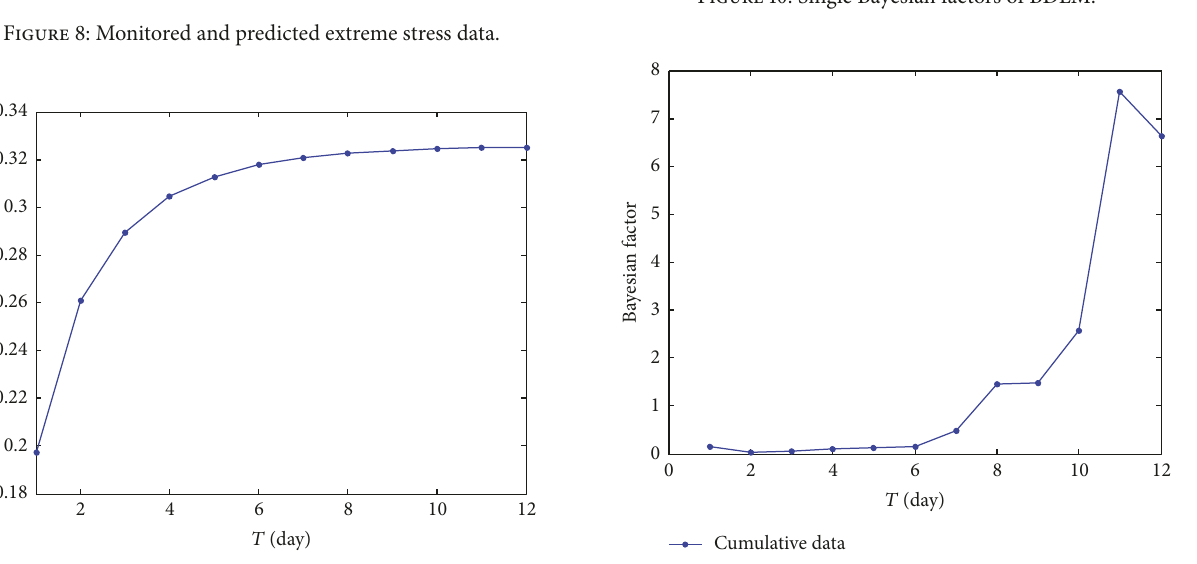
Figure 9: Prediction precision of BDLM.